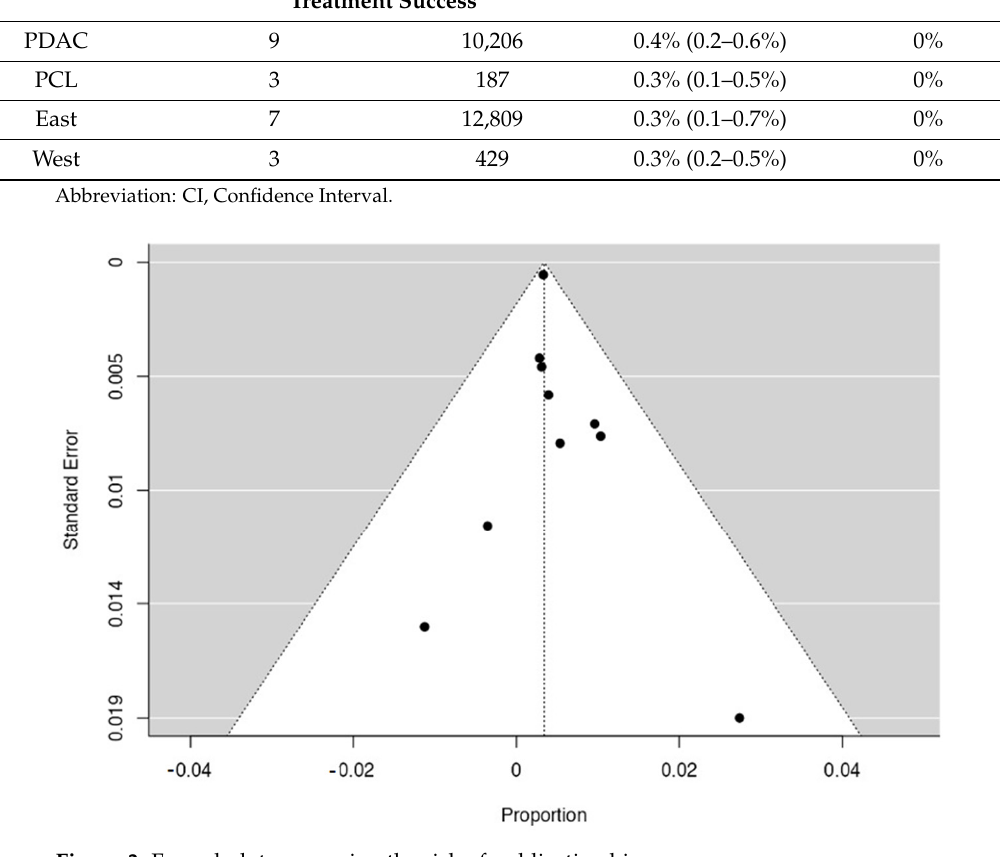
Figure 3. Funnel plot concerning the risk of publication bias.